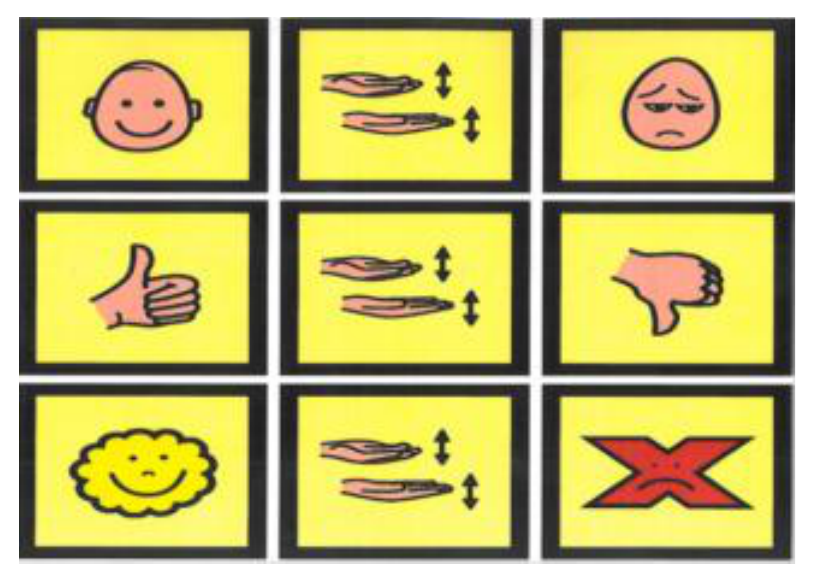
Figure 1. Symbols used for the Talking Mat visual scale–1 is chosen for use. The Picture Communication Symbols ©1981–2012 Dynavox Mayer Johnson are used with permission. All rights reserved